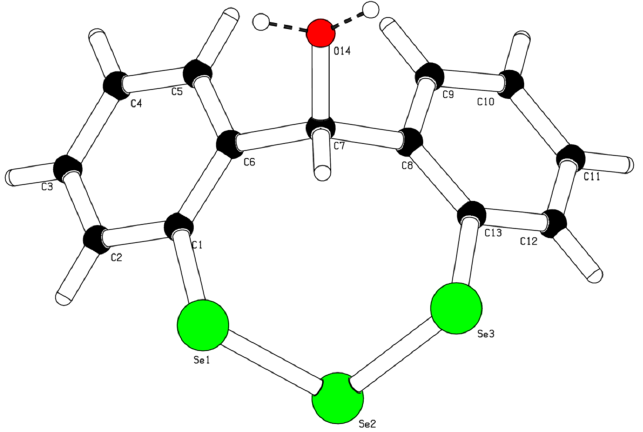
Figure 2. Crystal structure of the title compound 5 . Hydrogen atoms at O14 are half occupied.